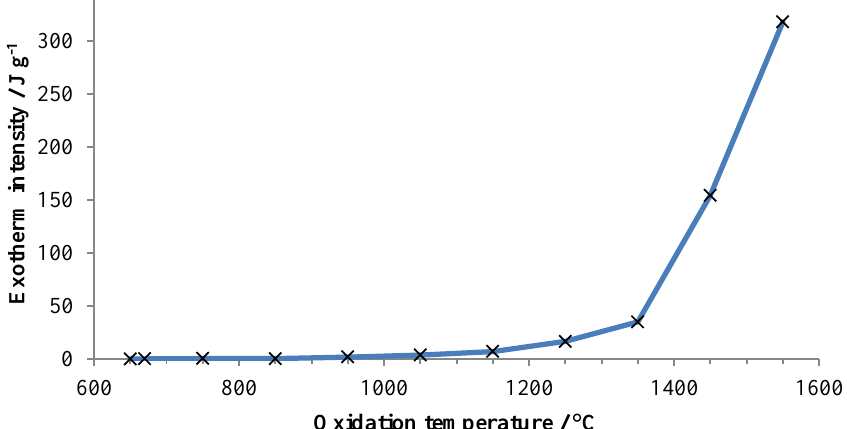
Figure 3. Energy released upon first exposure ofaluminum to air versus temperature of exposure. Energy is normalized to the total specimen mass at the beginning of the experiment.